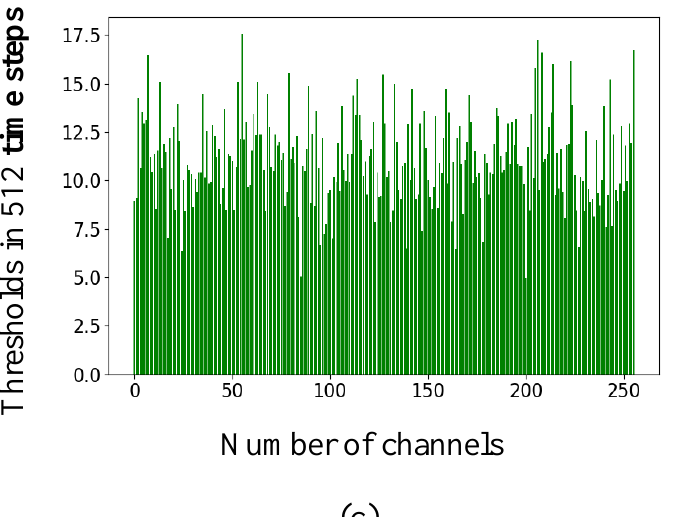
Figure A5. Assigned threshold values of the soft-reset IF neurons in the SNN on the Fashion-MNIST dataset. ( a ) assigned threshold of the soft-reset IF neurons in the first layer; ( b ) assigned threshold of the soft-reset IF neurons in the second layer with the latency of 4 time steps; ( c ) assigned threshold of the soft-reset IF neurons in the second layer with the latency of 512 time steps.